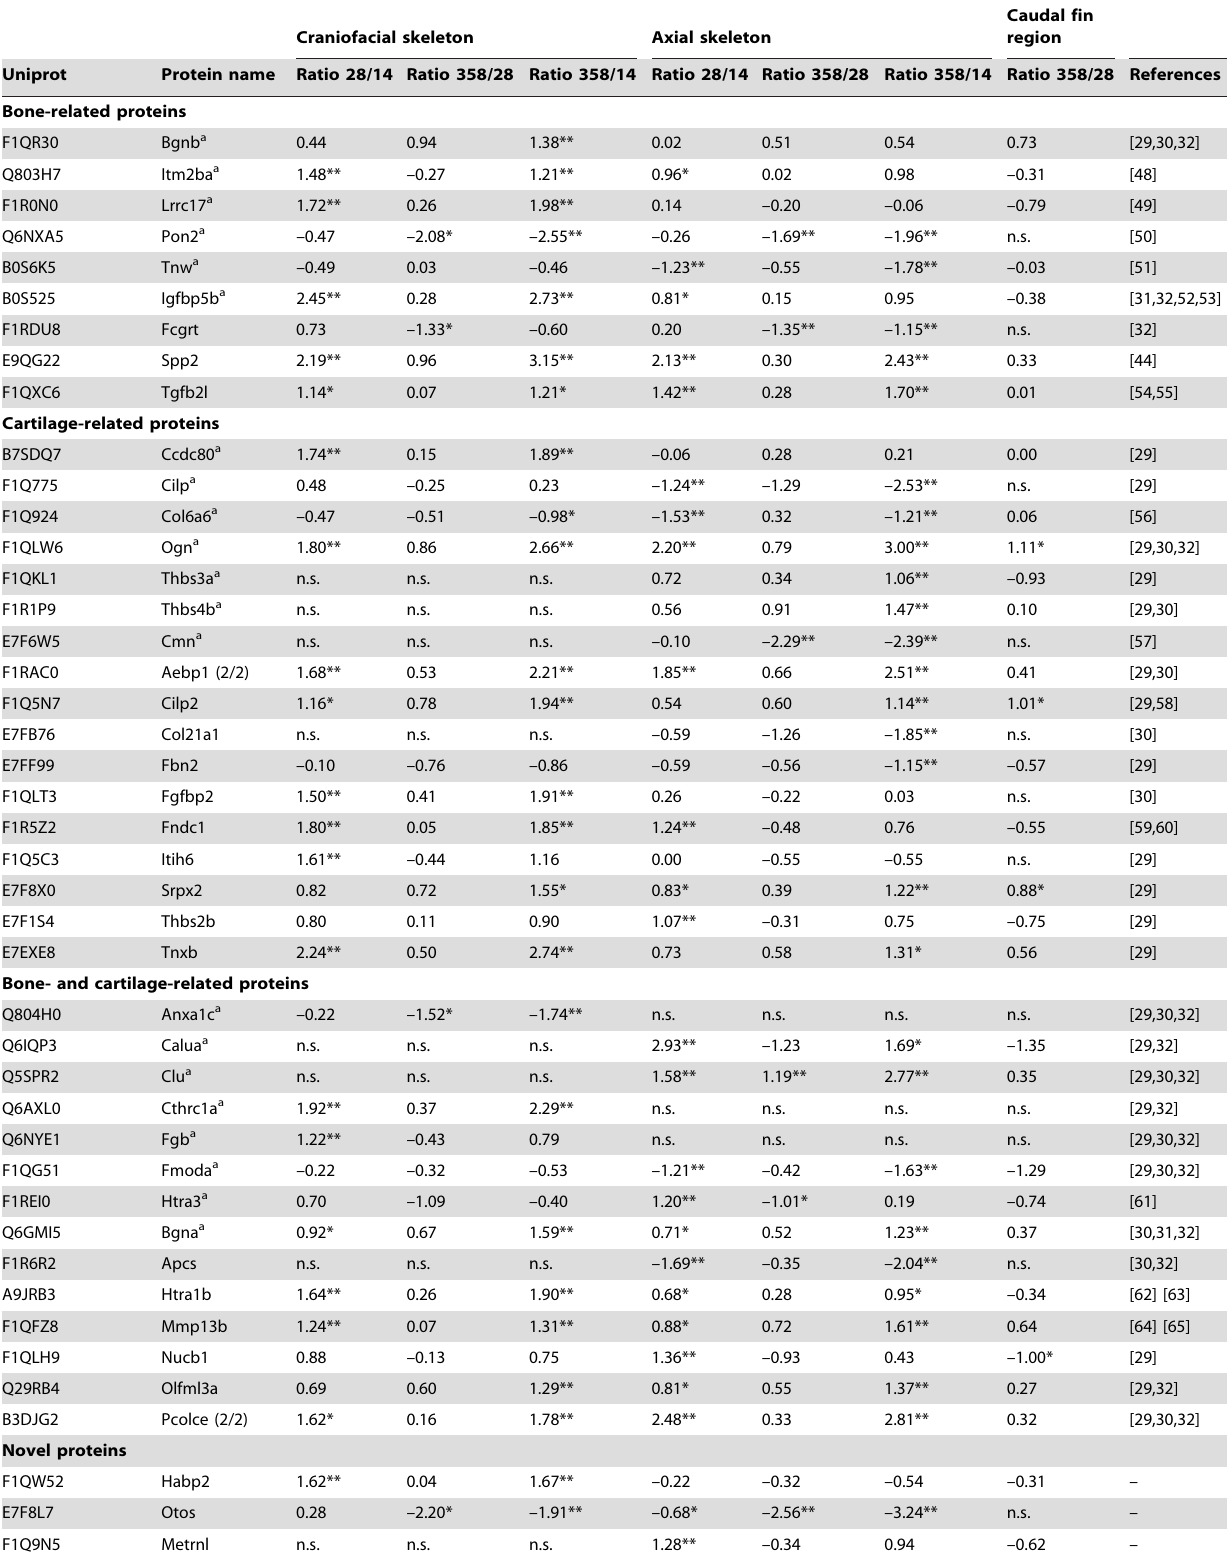
Caudal fin region